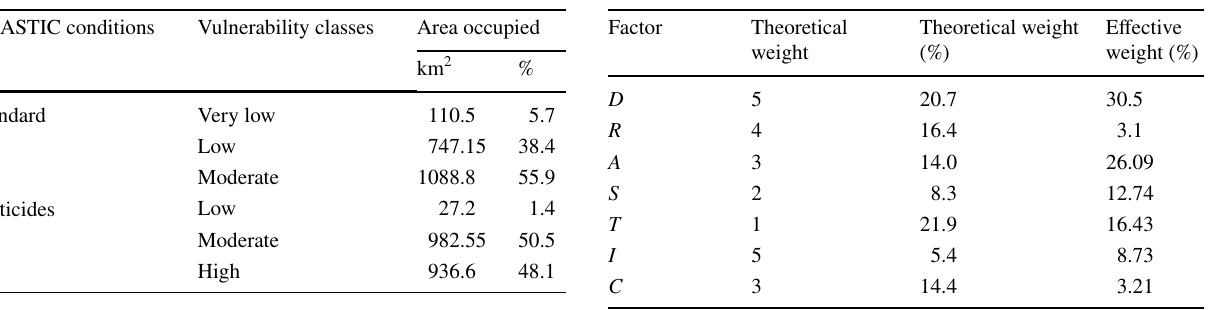
Table 8 The statistical summary of the DRASTIC factors maps DRASTIC factors